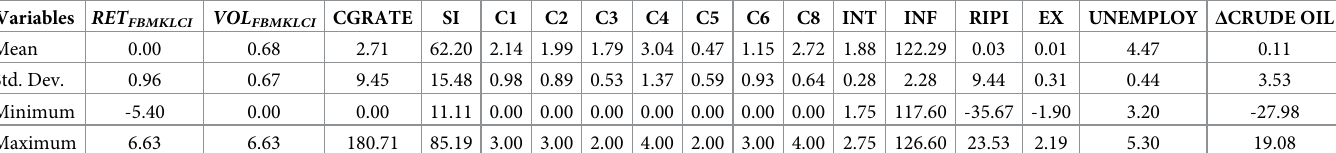
Table 1. Descriptive